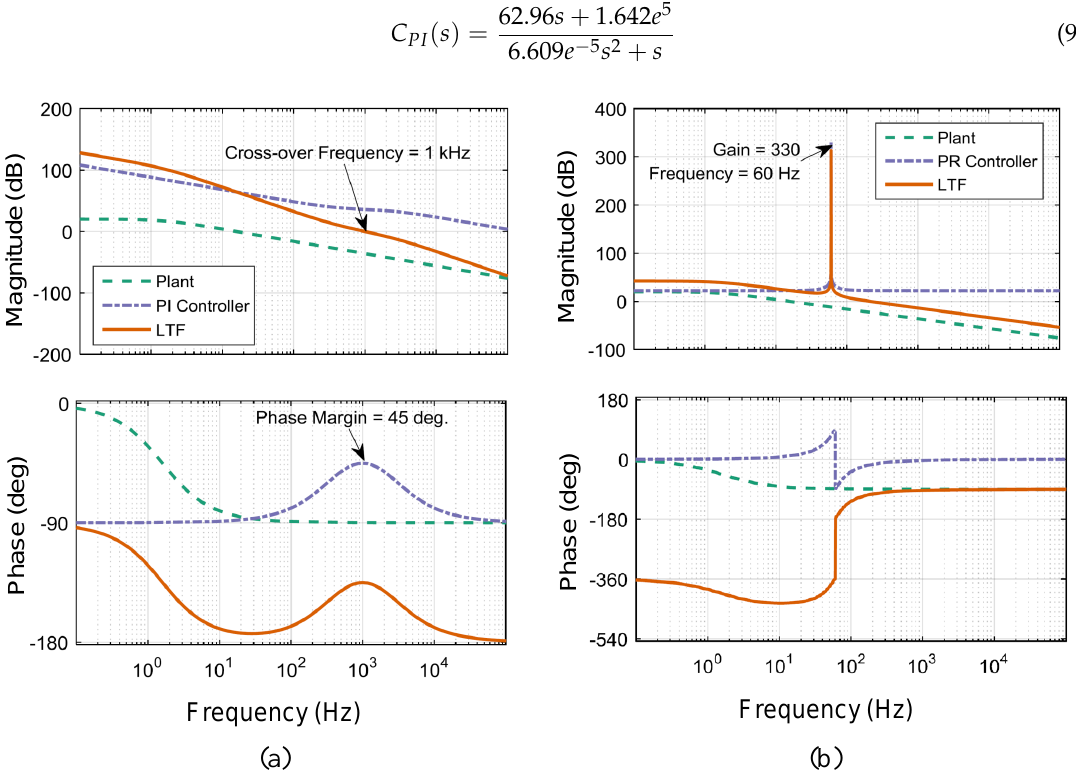
Figure 7. Frequency response of the plant, the designed controller, and the loop transfer function (LTF) of the overall system. ( a ) PI Type-2 controller. ( b ) PR